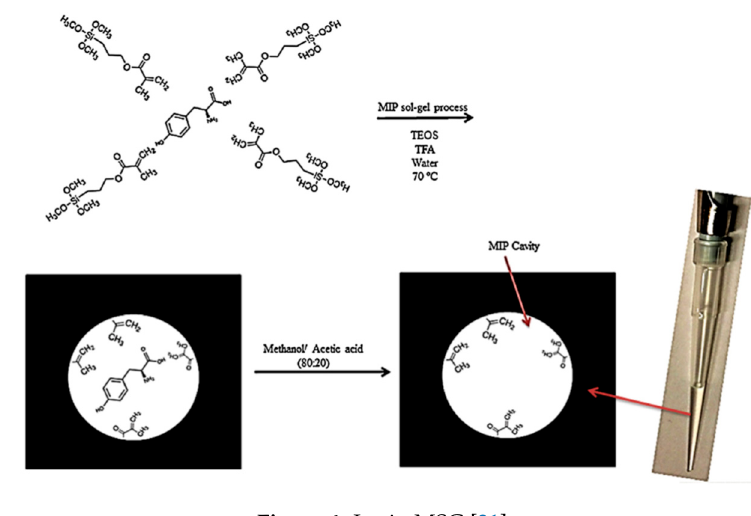
Figure 4. In-tip MSG [31].